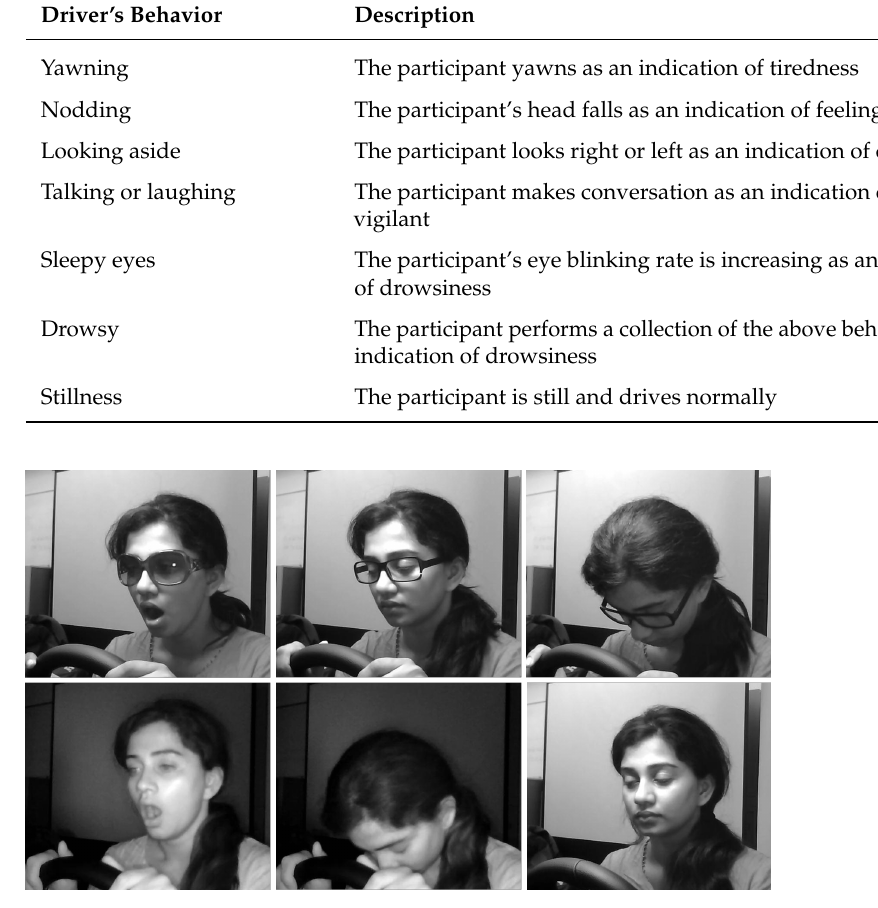
Figure 3. Sample images for the same behavior but changing conditions.